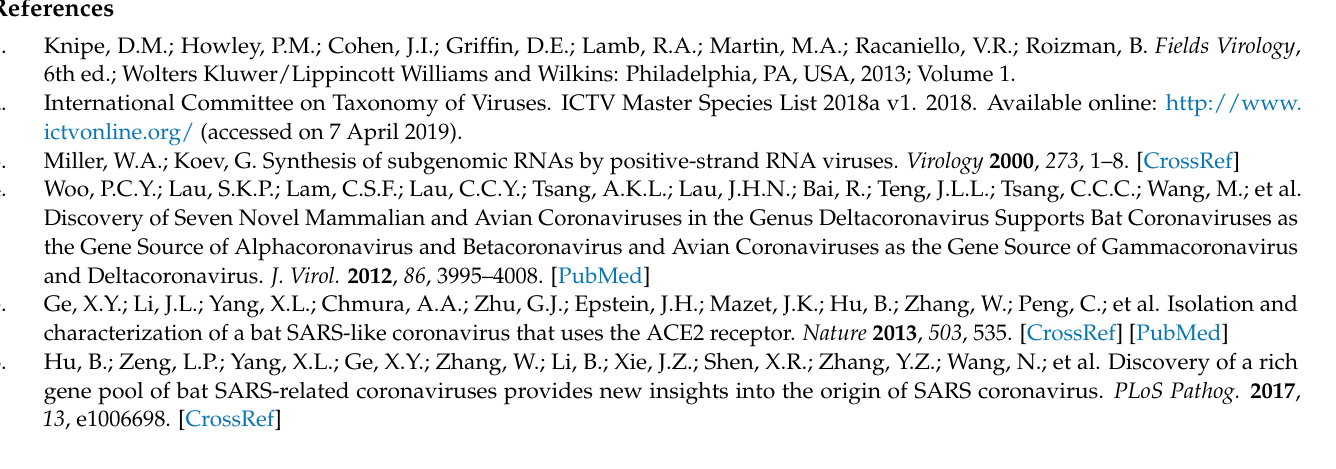
terization of BtCoV HKU10 spike mediated pseudovirus. Figure S3: Phylogenetic tree of BatCoV HKU10. Table S1: Primer pairs for HKU10 detection and genome sequencing. Table S2: Detection of HKU10 in bats by RT-PCR. Table S3: Genome size, coding potential, and putative transcription regulatory sequences of 11 BtCoV HKU10 strains. Table S4: Comparison of whole genomes (nt) and coding regions (aa) of representation strains of BtCoV HKU10. Table S5: Susceptibility test of Ro-BtCoV HKU10 and BtCoV HKU10